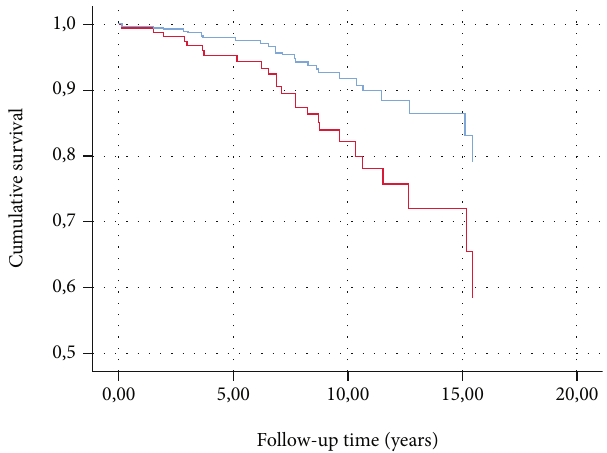
Figure 2: Cumulative survival by DSPN status at baseline in type 1 diabetes patients. Cox proportional hazard model adjusted for age, sex, and current smoking. Curves are fi tted for populations with a mean age of 45 years, 53% male, and 36% smoker at baseline. Presence of DSPN at baseline — red line. Absence of DSPN at baseline — blue line. DSPN: distal symmetric